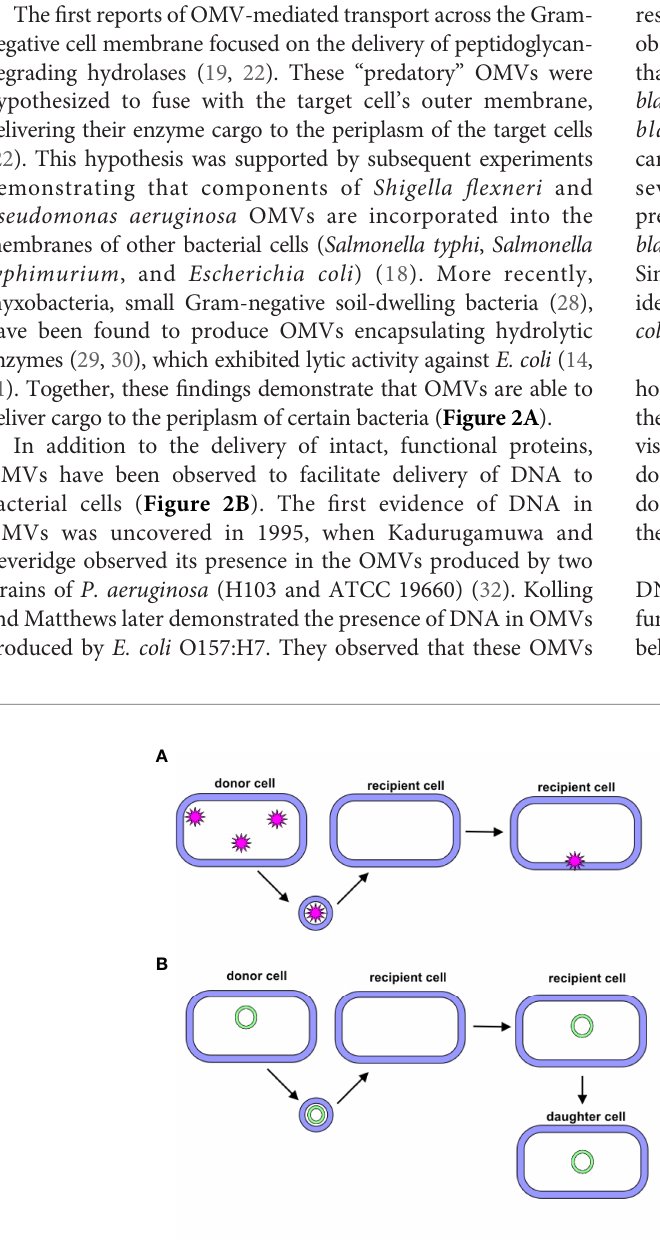
FIGURE 2 | Natural Delivery Functions of OMVs. (A) Protein Delivery. Proteins derived from a donor cell are encapsulated within OMVs and delivered to recipient cells. (B) Gene Delivery. DNA (plasmid, chromosomal, and/or phage-associated) is encapsulated within OMVs and delivered to recipient cells. In some cases, this new gene is expressed by daughter cells. (C) C16-HSL and CAI-1. Hydrophobic quorum sensing molecules, such as C16-HSL and CAI-1, have been observed to be delivered to bacterial cells via OMVs. (D) Quorum sensing. PQS is a hydrophobic quorum sensing molecule. As it intercalates into the outer lea fl et of the bacterial membrane, a wedge-like force promotes the formation of PQS-containing